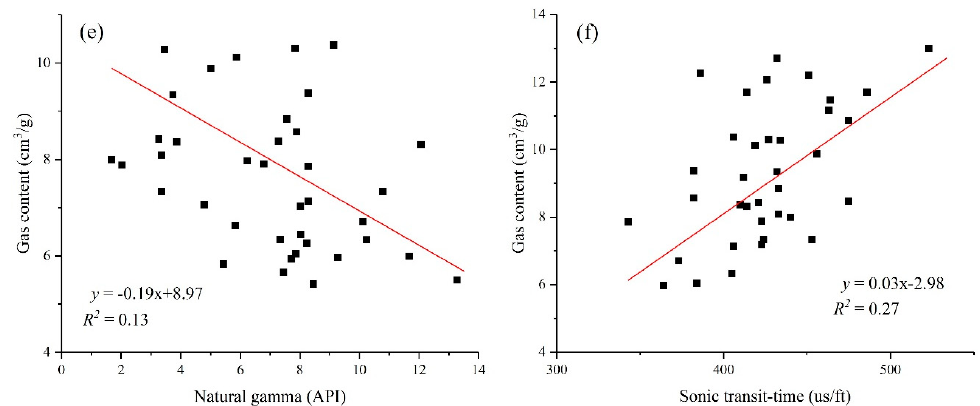
Figure 4. The fitting relationship between density and ash content ( a ); the fitting relationship between gas content and density ( b ), neutron ( c ), deep lateral resistivity ( d ), natural gamma ( e ), acoustic time ( f ). Table 3. The gas content fitting formulas with CNL and DEN.